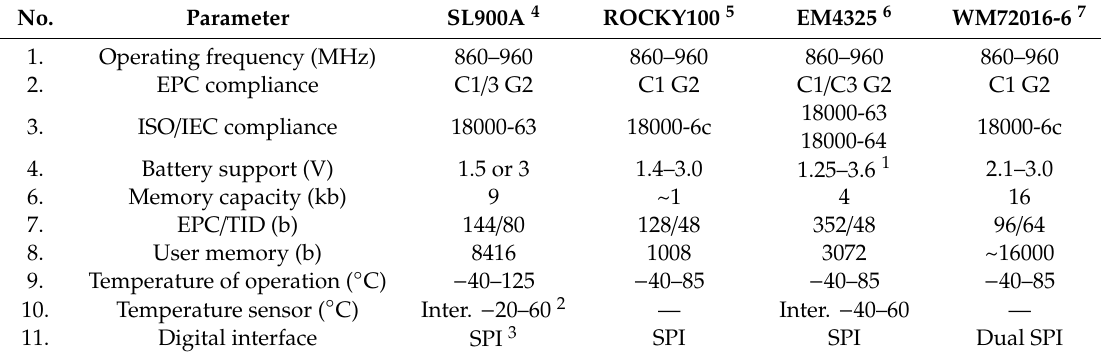
Table 1. Selected parameters of commercial chips dedicated to semi-passive RFID transponders of the UHF